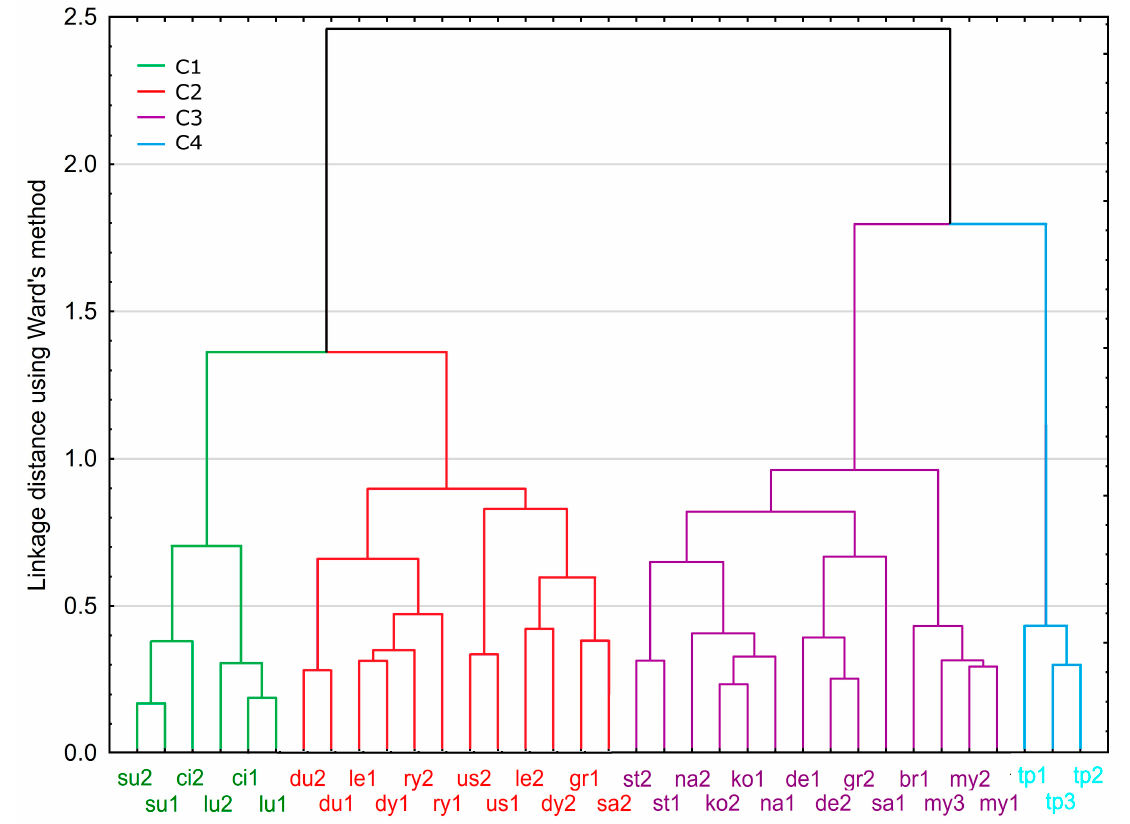
Figure 2. Results of clustering analysis. Distinguished clusters (C1–C4) are marked.